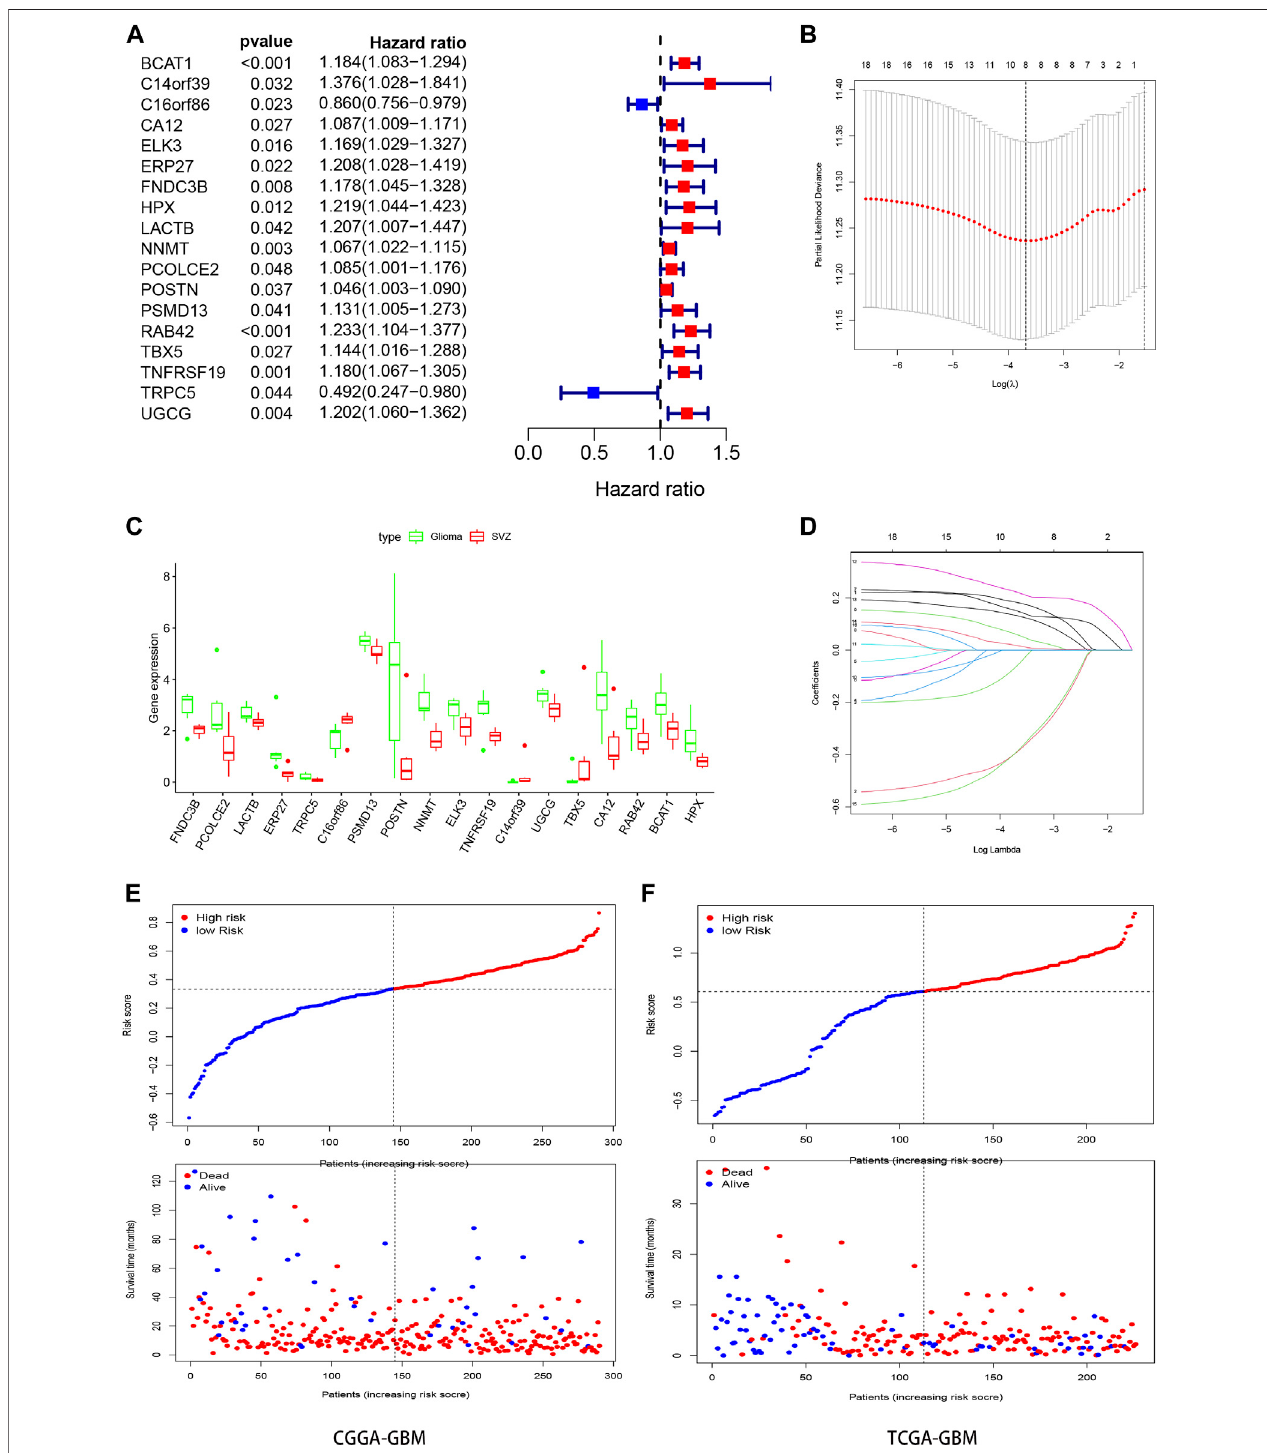
FIGURE 3 | Construction the SVZ-related prognostic signature. (A) Forest plots showing the results of the univariate Cox regression analysis between gene expressionandOS. (C) BoxplotshowedtheexpressionofthesegenesinSVZ(red)andGBM(green). (B,D) Lassoregressionidenti fi es8genes(BCAT1,C16orf86,HPX, NNMT, RAB42, TBX5, TNFRSF19, and TRPC5) in the prognostic signature for GBM and the coef fi cients of the signature. (E,F) Classi fi cation of GBM patients in CGGA and TCGA into high- and low- risk groups based on the median of risk score.